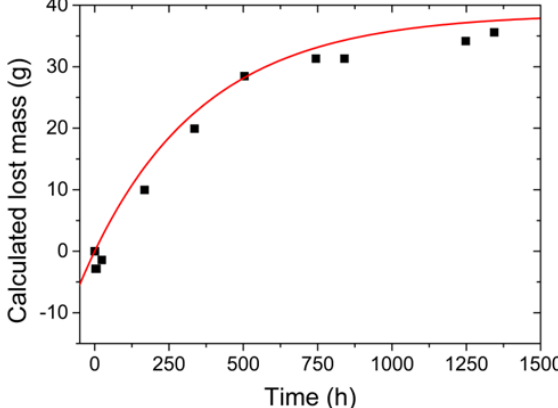
Figure 4. Variation of the calculated lost mass with time using Equation (6) (red line) and the obtained values from Table 1 (black squares).